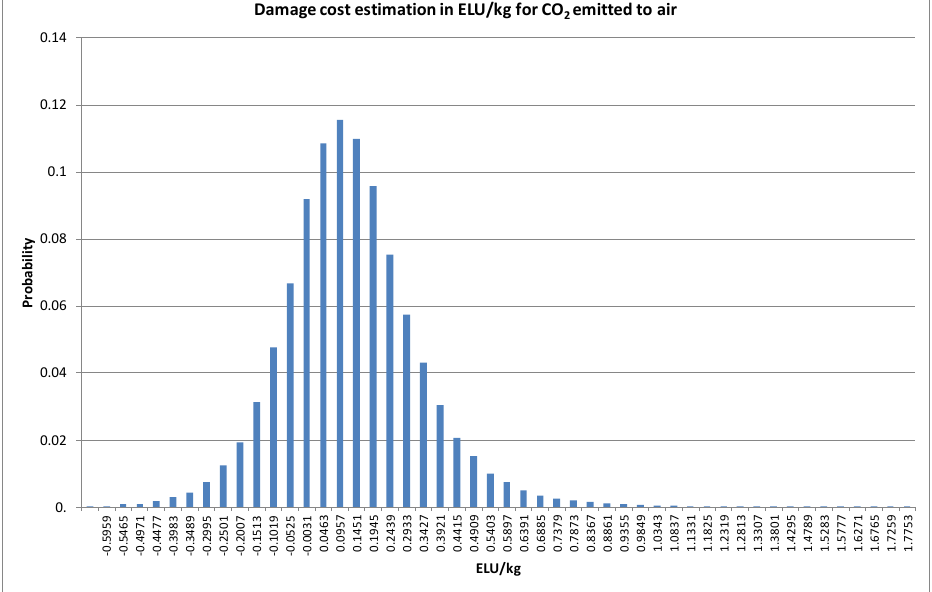
Figure 7. Probability density function in EPS2015 for the environmental damage cost of emitting 1 kg CO 2 in air.